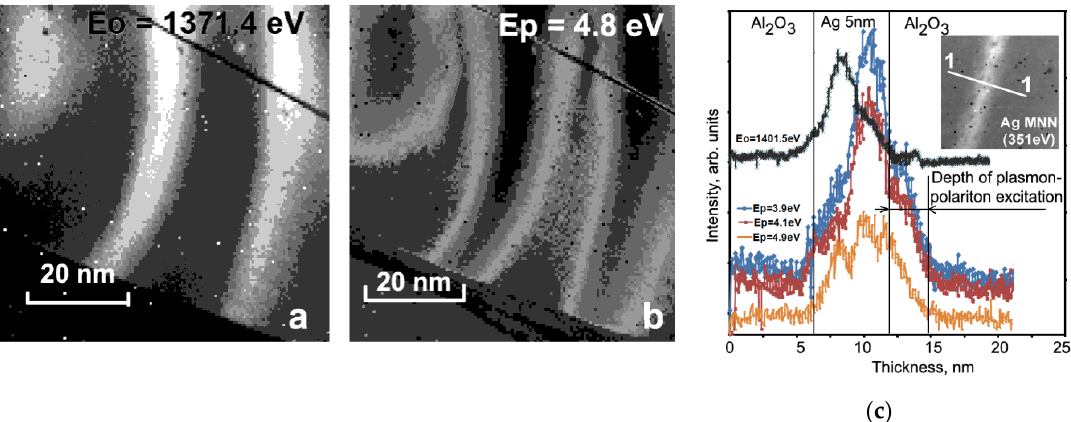
Figure 10. Structure of Ag/Al 2 O 3 5/24 multilayer coating: ( a ) back scattered electron image (BEI) of angle lap; ( b ) map of plasmon excitation at E p = 4.8 eV; ( c ) linear distribution of plasmon excitations across 1–1 direction on insert of Auger Ag MNN image (AEI). E 0 is energy of back scattered electrons; E p –energy of plasmon resonance.